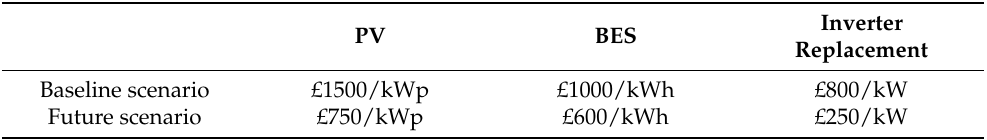
Table 4. Capital costs in the baseline and future